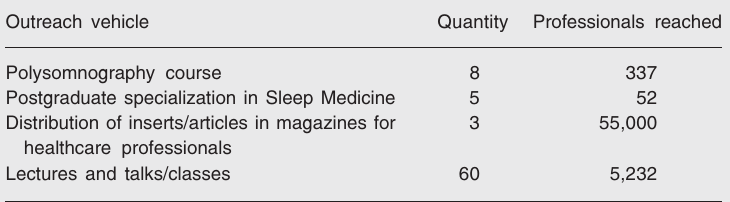
Table 2. Initiatives to reach healthcare professionals